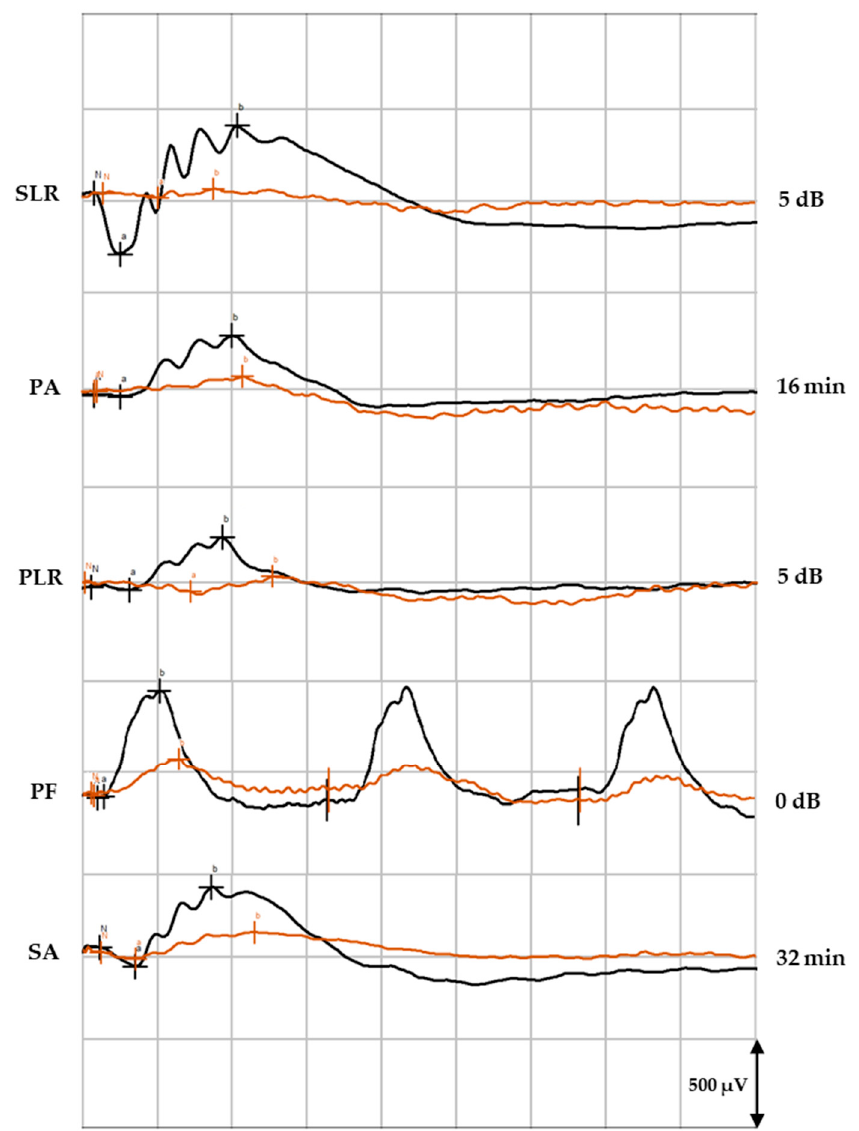
Figure 3. Example of ERG waveforms recorded from the OD at the beginning of the study (black) and at day 3 after the glaucoma induction (orange) in an animal from the control group. a, a-wave; b, b-wave; N, zero/basis; SLR, scotopic luminescence response; PA, photopic adaptation; PLR, photopic luminescence response; PF, photopic flicker; SA, scotopic adaptation; dB, decibel; min, minutes.